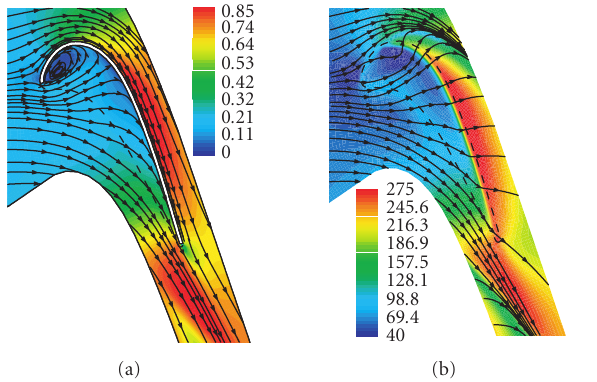
Figure 16: Streamtraces superimposed on Mach number contours at (a) the mid-height of the rim and (b) the mid-height of the tip gap for the baseline suction-side